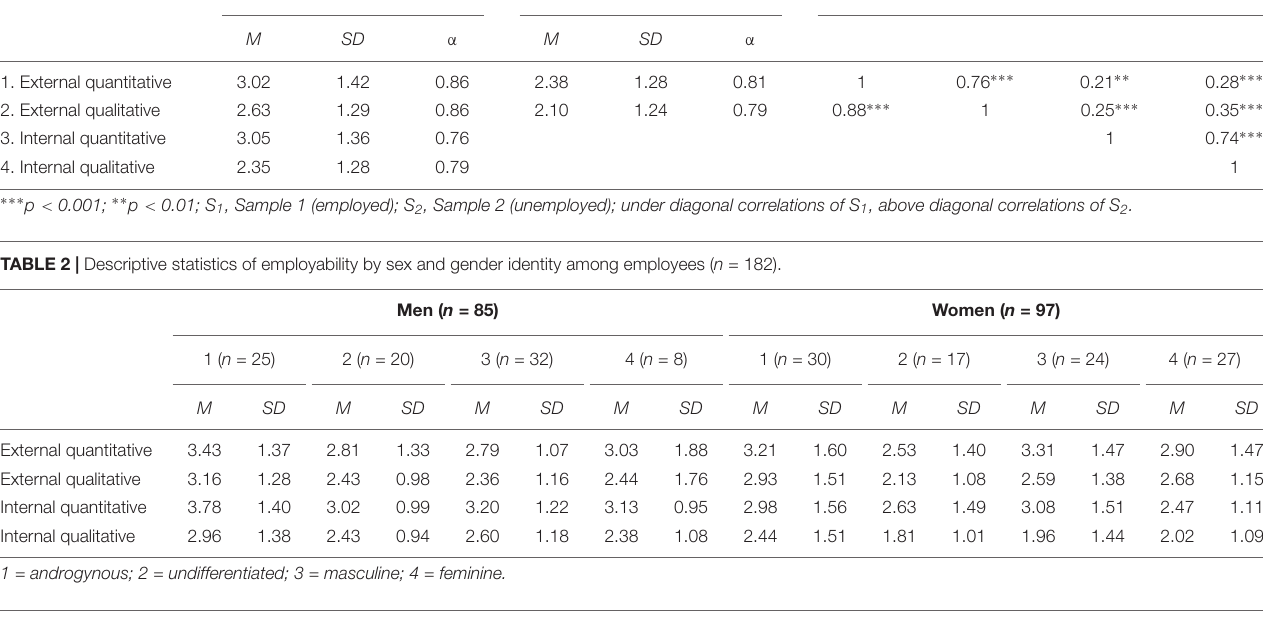
TABLE 1 | Means, standard deviations, and correlations for employed ( n = 182) and unemployed ( n = 237). Employed Unemployed